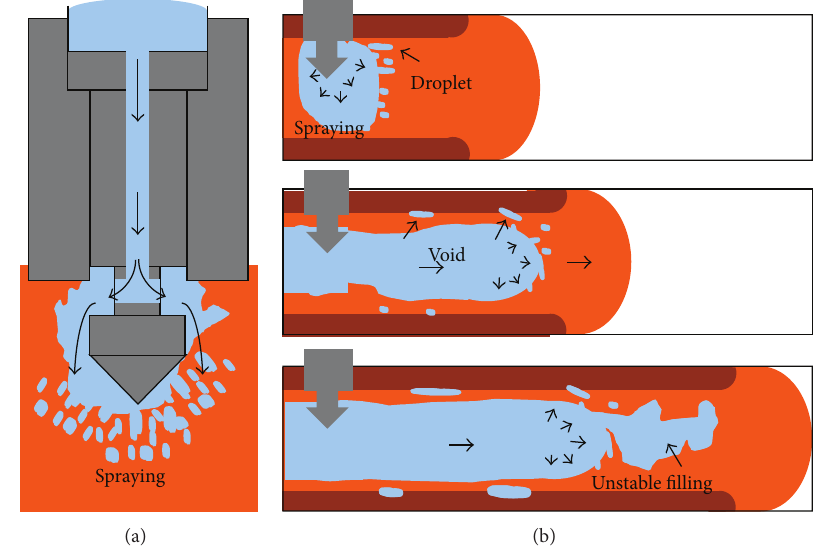
Figure 8: Spraying effect and unstable filling by nozzle